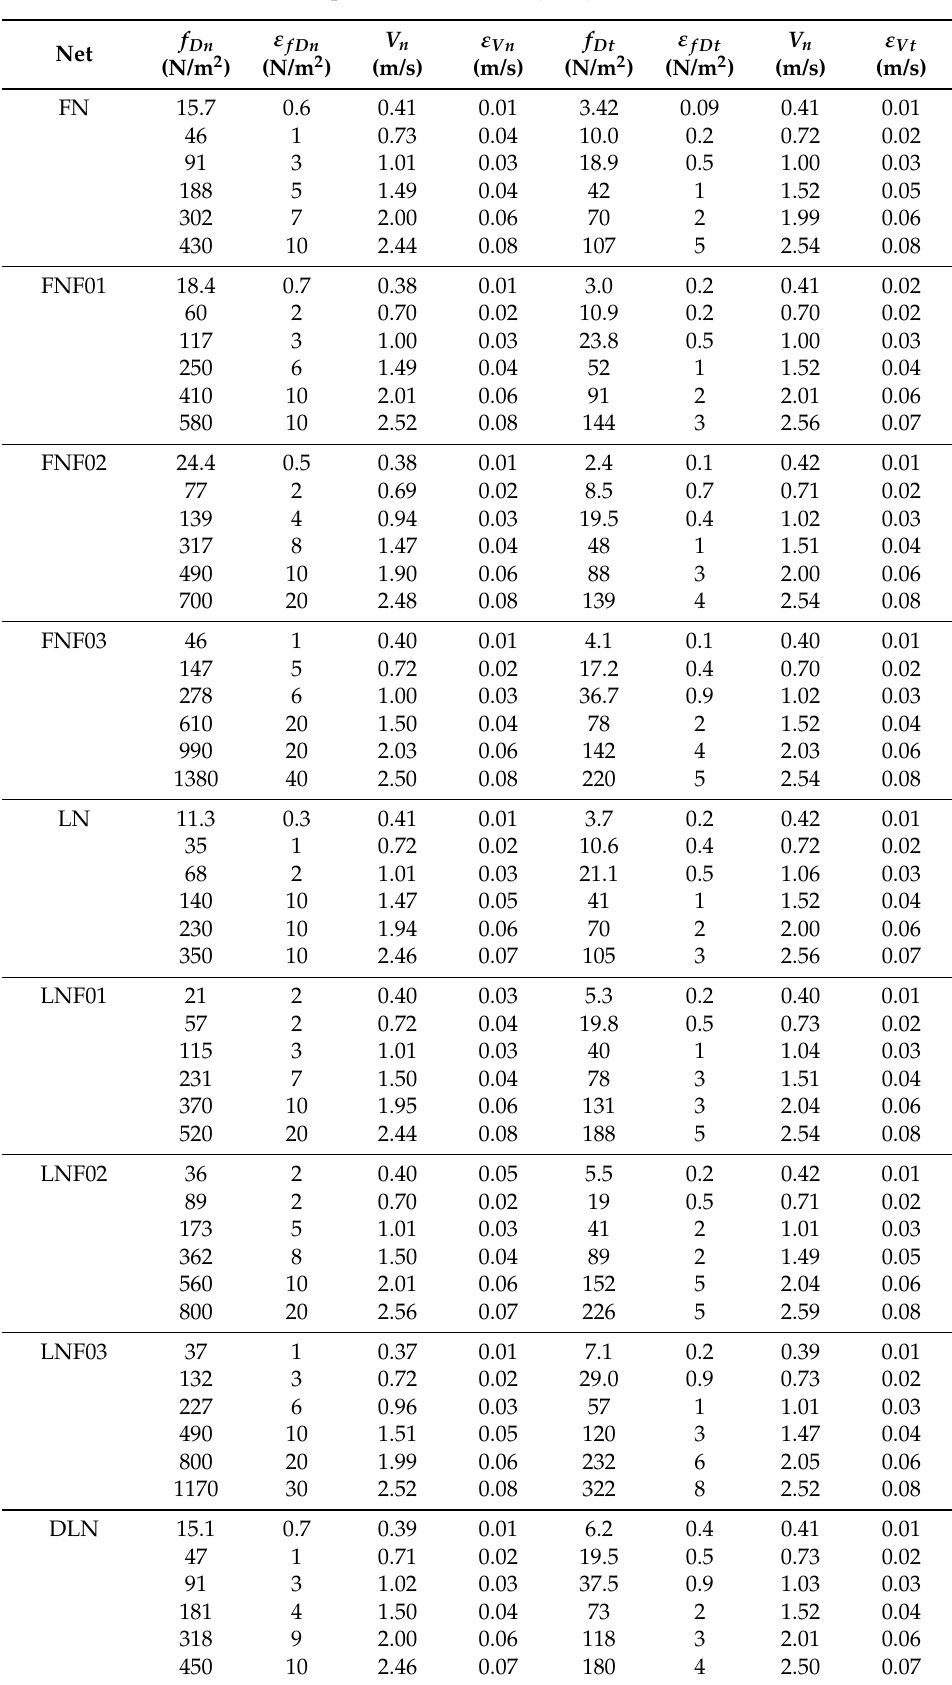
Table 2. Experimental values of f Dn , f Dt , V n , and V t